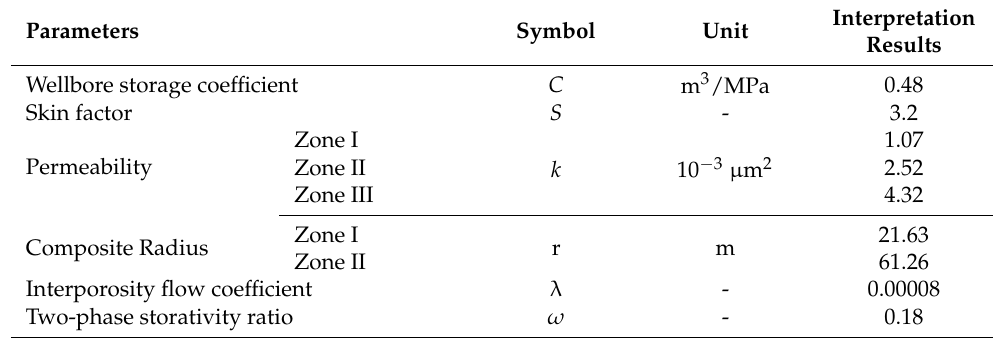
Table 3. The interpretations of the results of Well